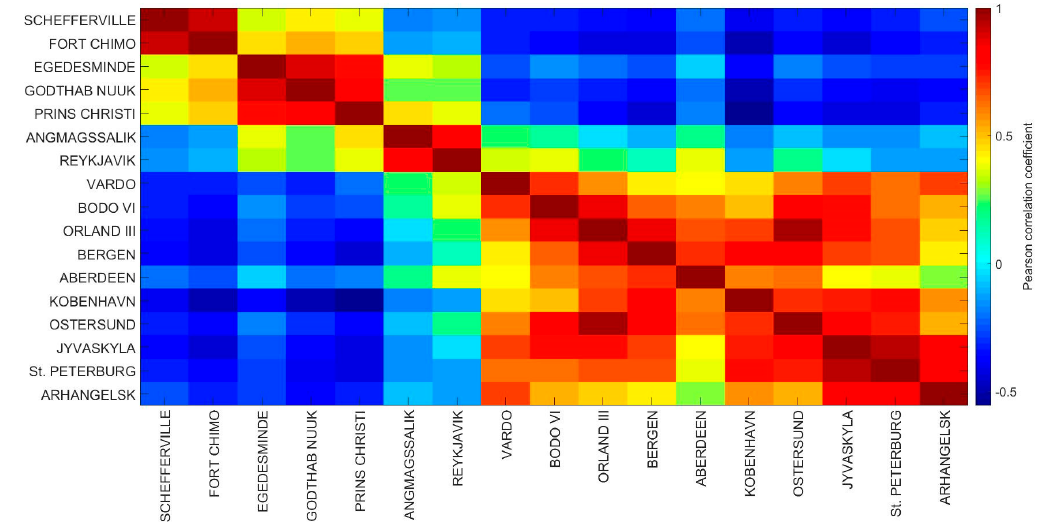
Figure 2. Pearson correlation coefficients among all weather stations in January (1951–2016 period).